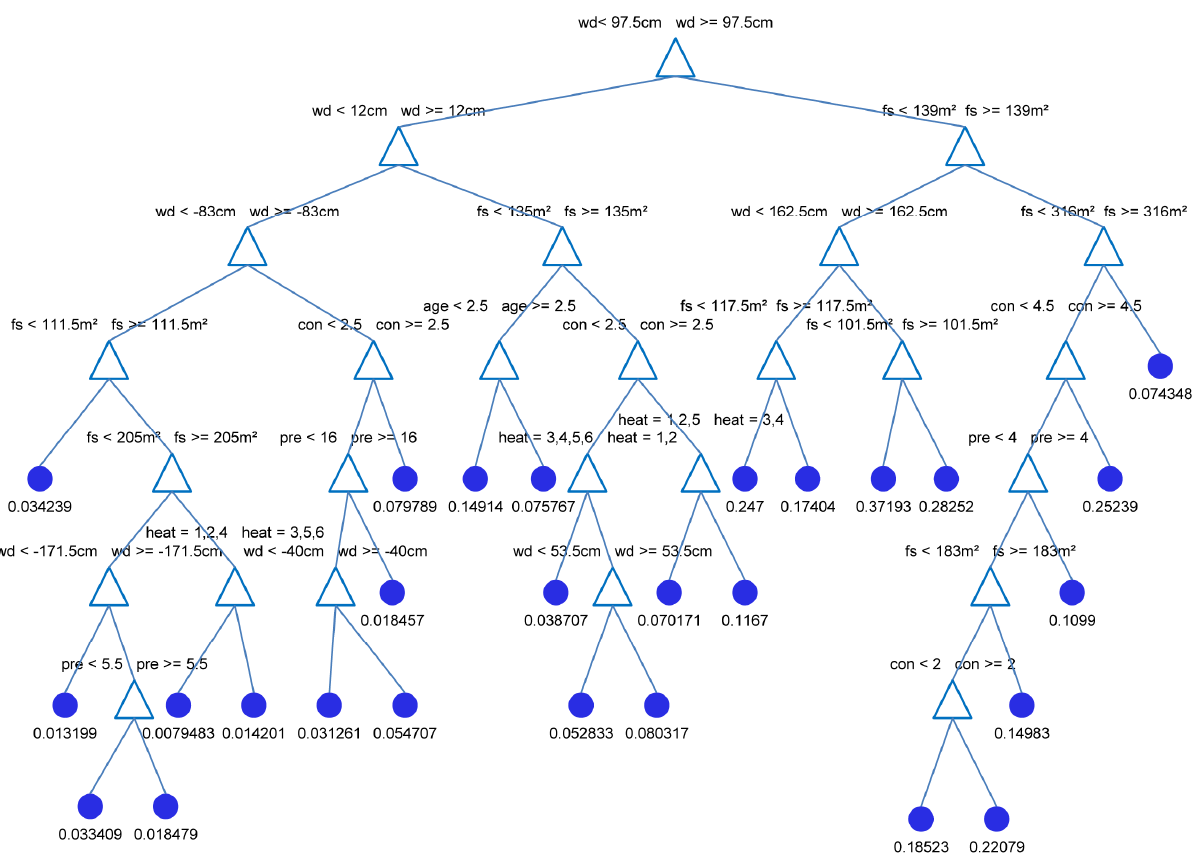
Figure 5. Structure of the regression tree RT1. Abbreviations: wd = water depth, fs = floor space, age = age of building, heat = heating system, con = contamination, pre = precaution. Triangles represent the decision nodes, dots are calculated loss ratios.